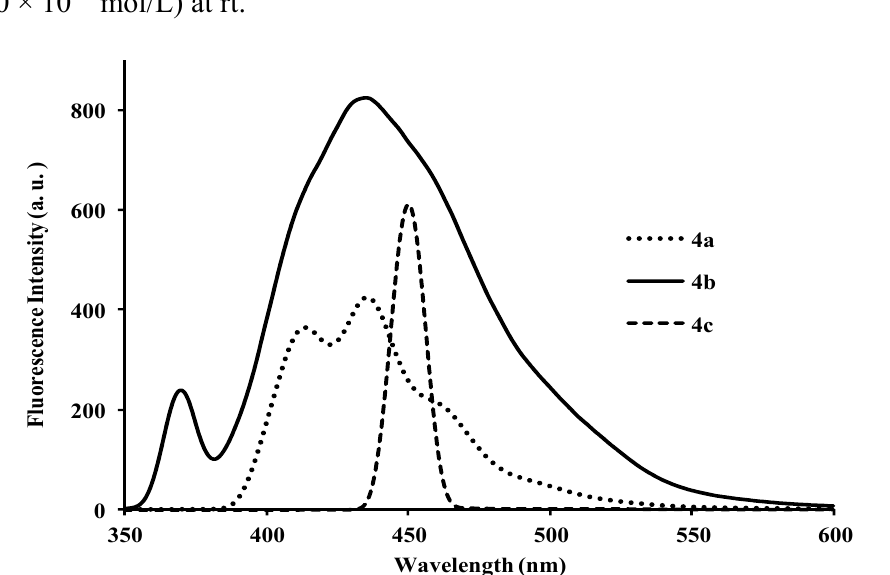
= 368 nm) in DMF ex